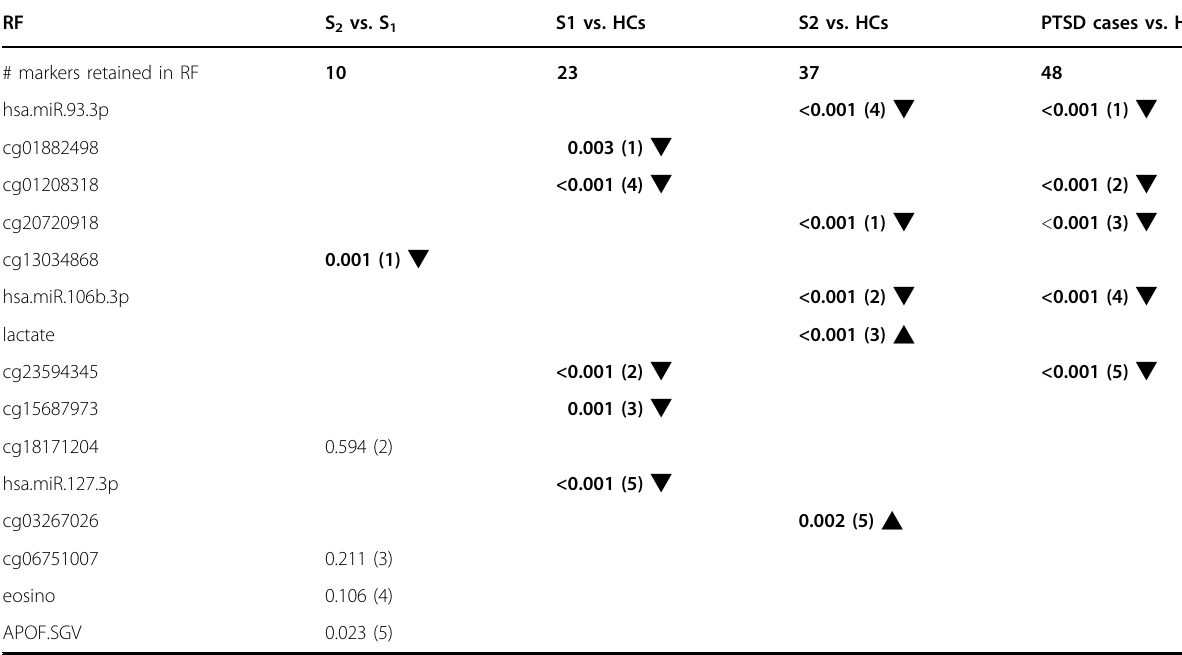
Table 4 Signi fi cance* of difference in mean marker values and direction of dysregulation in the more severe group in intergroup comparison for top 5 RF important a